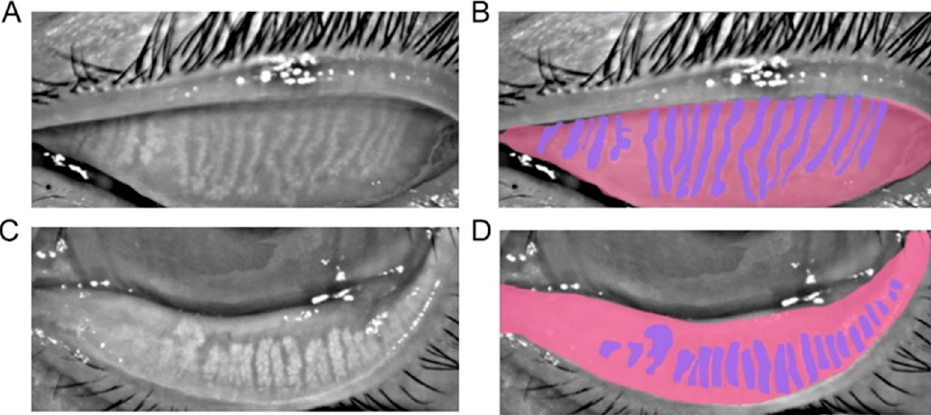
Figure 1. ( A , B ): A representative of meibography of the upper tarsus and its annotation; ( C , D ): A Figure 1. A and B : A representative of meibography of the upper tarsus and its annotation; C and representative of meibography of the lower tarsus and its D : A representative of meibography of the lower tarsus and its annotation.